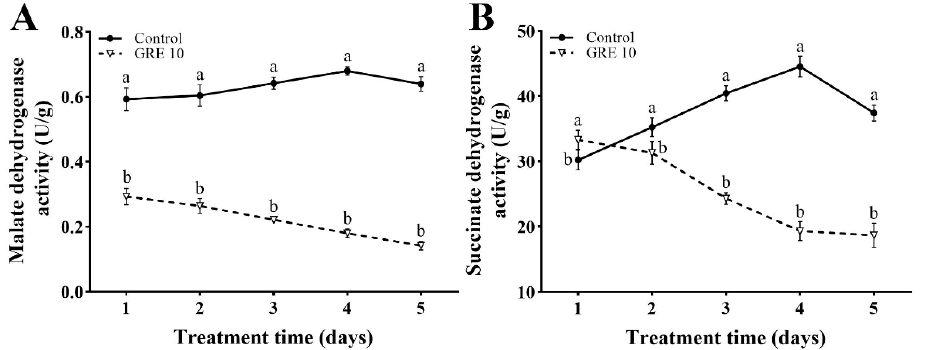
Figure 5. Effects of 10 mg/mL GRE on MDH ( A ) and SDH ( B ) activities in F. solani . The bars on the curves represent standard deviations, and different letters at the same time point represent significant differences ( p < 0.05).